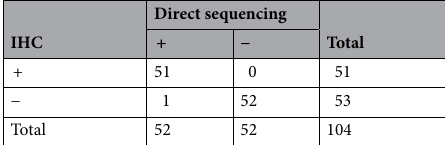
Table 4. Consistency analysis of two groups between IHC and direct sequencing method in IDH1-R132H detection.